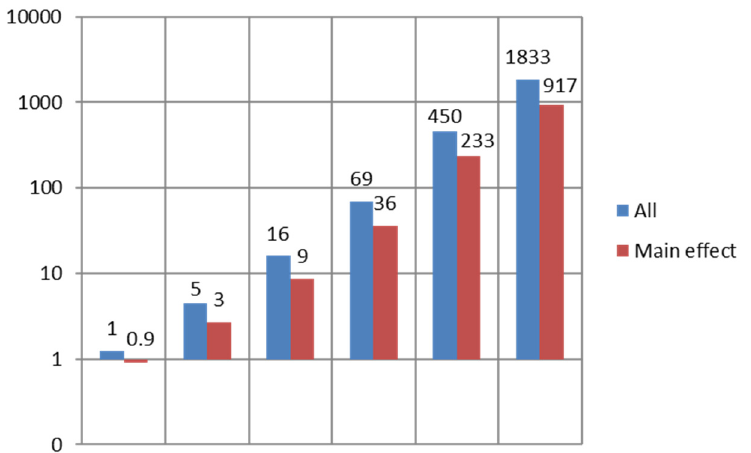
Figure 4. Computation time for a microbiome GWAS with 500,000 SNPs. “Main”: computation time for testing main effect only. “All”: computation time for testing main effect, interaction and the joint null hypothesis H 0 : β M = 0, β I = 0 .